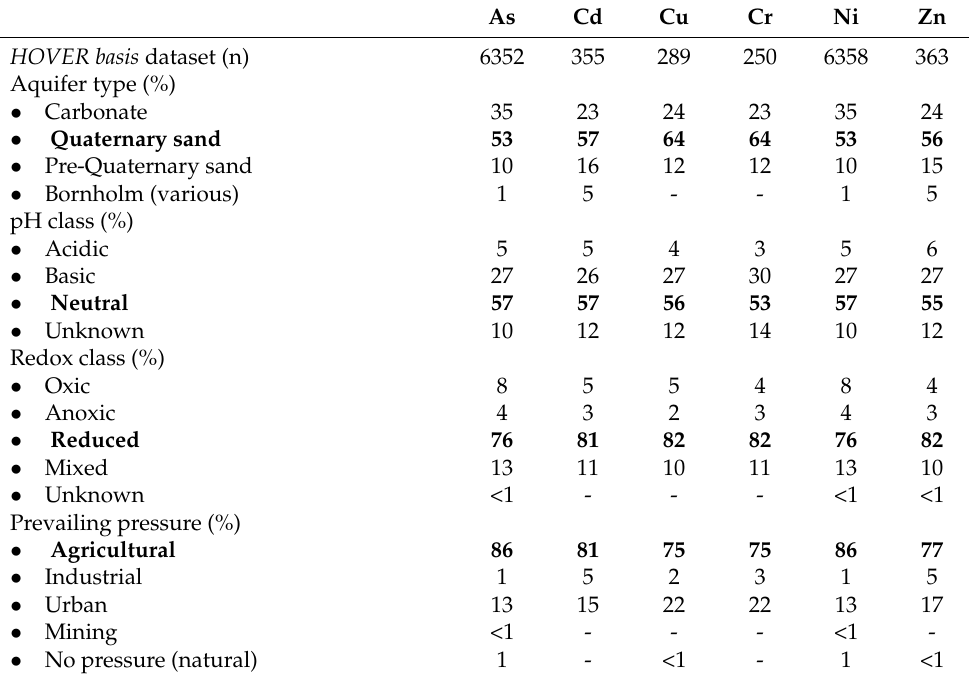
Table A2. Groundwater sampling points in each class; the dominating classes are shown in